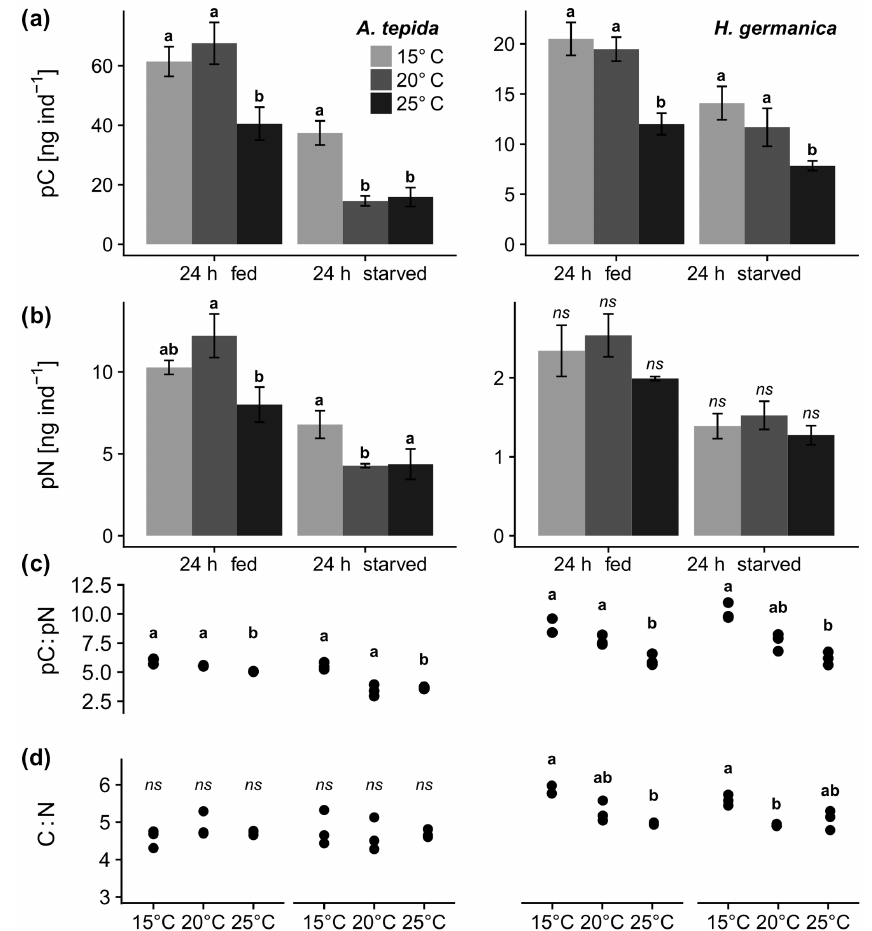
Figure 2. Comparison of pC and pN from diatom feeding in A. tepida and H. germanica after a 24h feeding period (24h fed) and 24h without food (24h starved) at 15, 20, and 25 ◦ C. Letters show significant differences of (a) cytoplasmic pC, (b) pN between incubation temperatures within the 24h feeding period/24h fed and the 24h incubation without food/24h starved, (c) pC : pN ratio ( n = 3 in all cases), and (d) ratios of foraminiferal cytoplasmic C : N; p < 0 . 05, pairwise permutation tests; ns denotes values that are not significant.